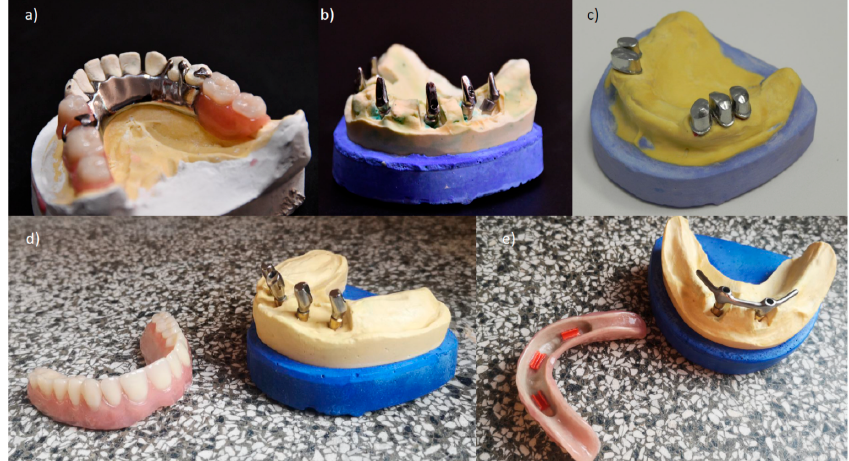
Figure 29. Examples of different prosthetic restorations and implants made of Ti6Al4V alloy by SLS: ( a ) skeletal prosthesis; ( b ) individual abutments for the round bridge; ( c ) primary telescopic crowns based on own teeth; ( d ) primary telescopic crowns integrated with individual abutments with an acrylate prosthesis; ( e ) individual bar with integrated individual abutments based on two implants with an acrylate prosthesis.